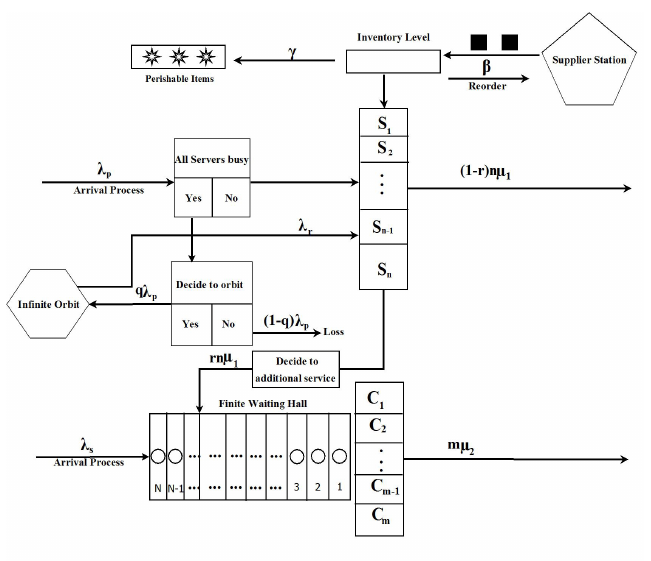
Figure 1. Graphical depiction of the